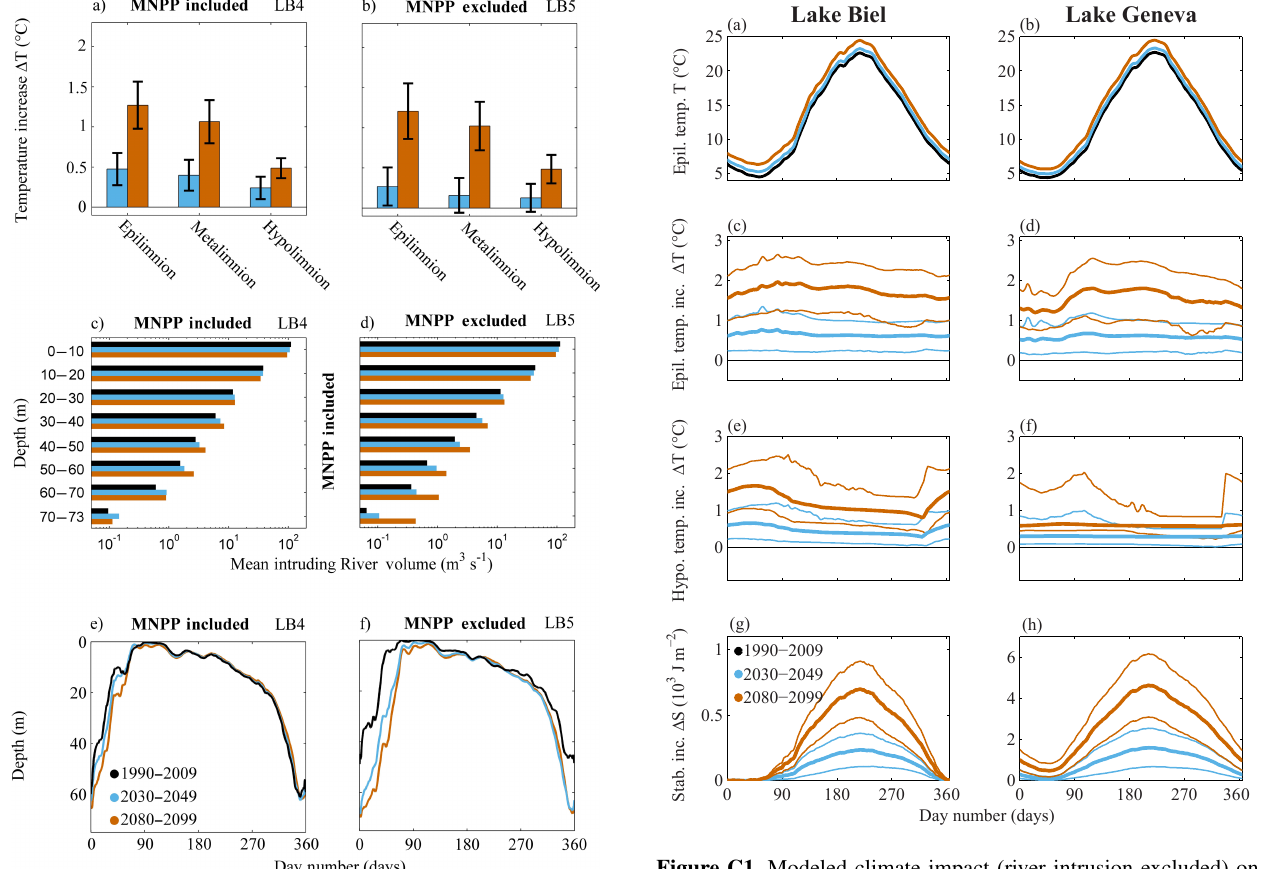
Figure C1. Modeled climate impact (river intrusion excluded) on LB (left column, scenario LB1) and LG (right column, scenario LG1) shown as daily mean (thick lines) and maximum/minimum model values (thin lines) for near-future (blue, 2030–2049) and far- future (orange, 2080–2099) time periods relative to the reference period (black, 1990–2009). Temperature T ( a and b ), temperature increase ( (cid:49)T ) in the epilimnion ( c and d ) and hypolimnion ( e and f ) as well as increase in stability ( (cid:49)S ; g and h